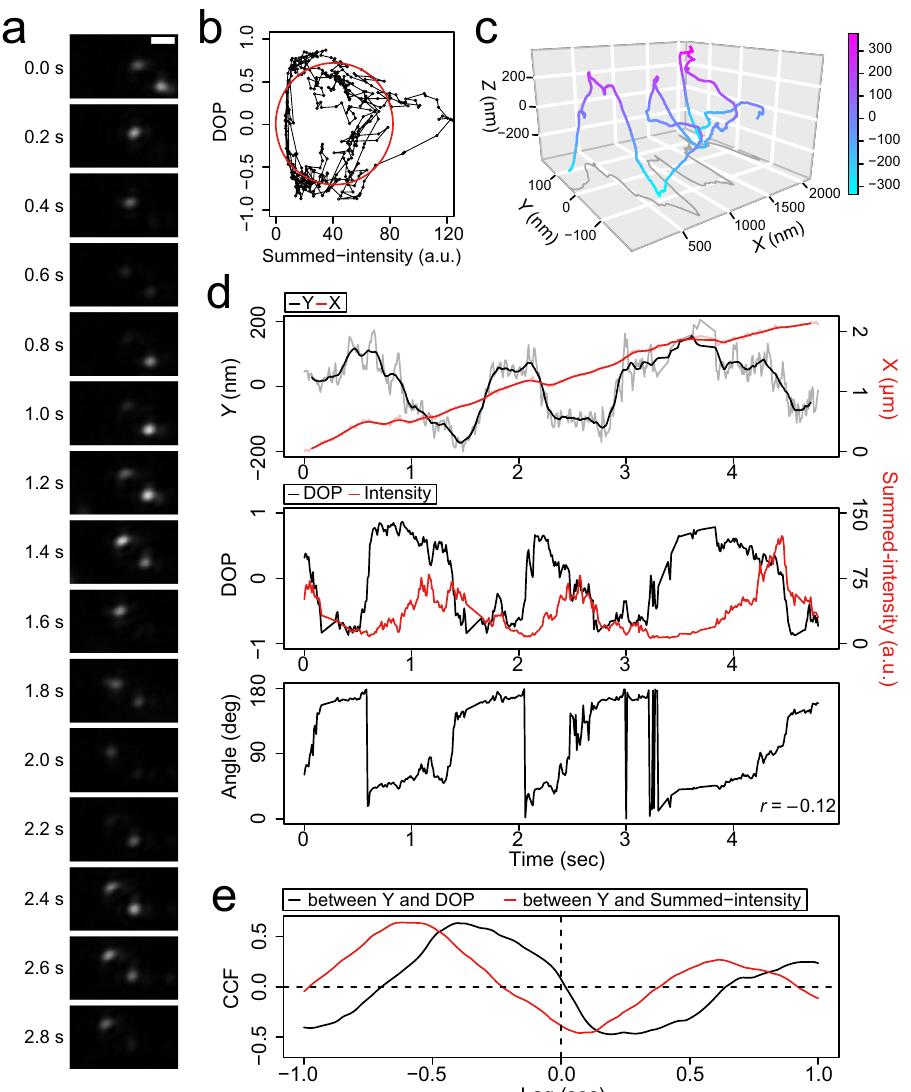
Fig. 2 Typical data of the GNR motility assay for KIF1A. a Montage of scattered-light images of one KIF1A-coated GNR (KIF1A-GNR) moving around a microtubule every 0.2 s in the presence of 2 mM ATP. The frame rate was 100 frames s -1 . Scale bar 2 μ m. b Degree of polarization (DOP) as a function of the summed-intensity of the two KIF1A-GNR spots shown in a . The red line represents an ellipse fi t. c 3D trajectory of the KIF1A-GNR through a moving- average fi lter of 15 frames. d The time trajectories of the X (red line)- and Y (black line)-displacements, the DOP (black line) and summed-intensity (red line) of the two spots, and the estimated angle of KIF1A-GNR shown in a . The value of r is Pearson ’ s correlation coef fi cient between the Y -displacement and the angle. e Cross-correlation functions (CCFs) between the Y -displacement and the polarization